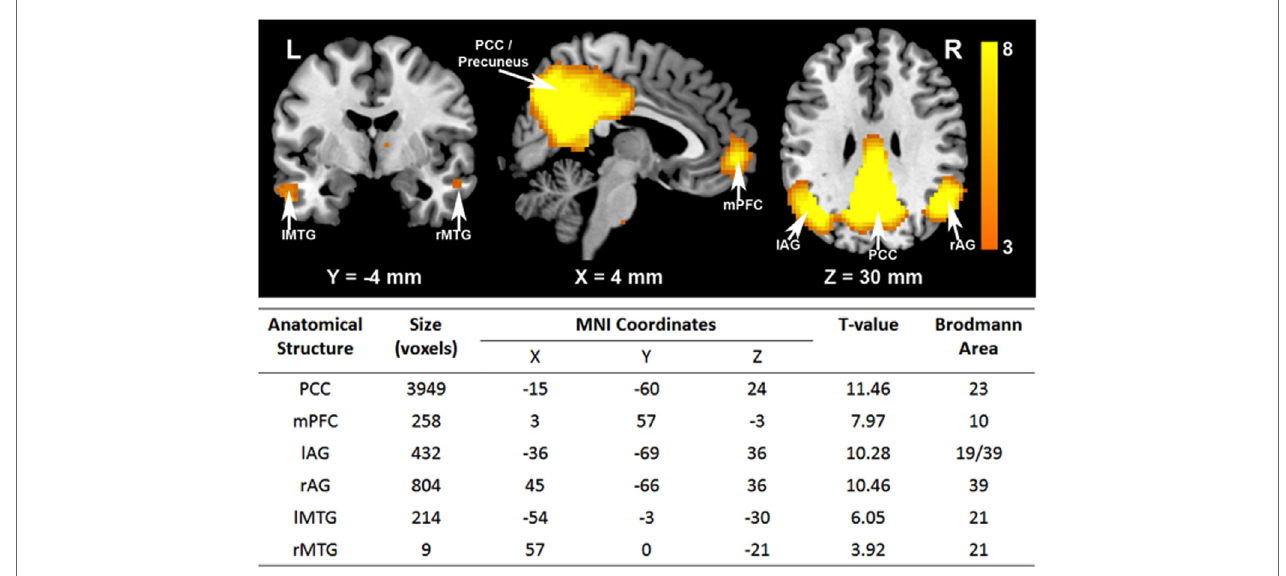
FigUre 1 | independent component analysis (ica) of DMn. Cortical regions of mPFC, PCC/Precuneus, bilateral angular gyrus (AG), and bilateral middle temporal Gyri (MTG) are activated.